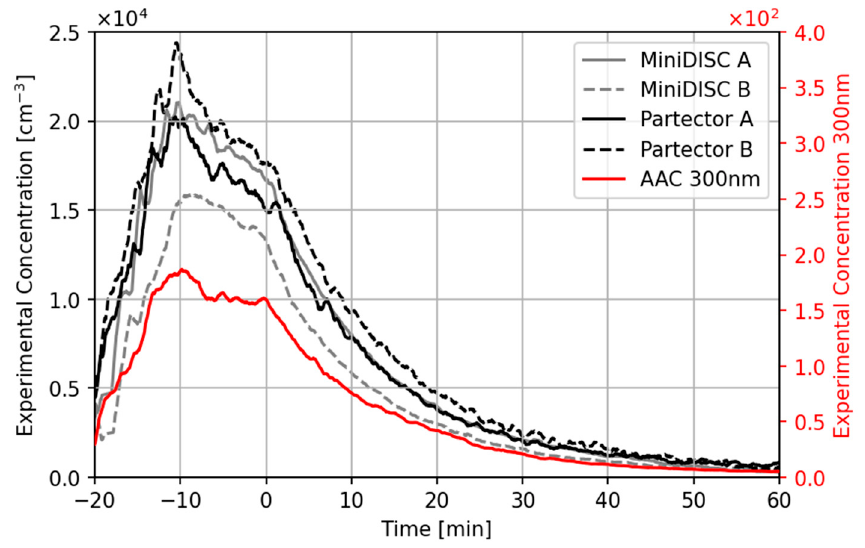
Figure 5. Concentrations measured with the different instruments before and after switching on the air cleaner at t = 0 min.